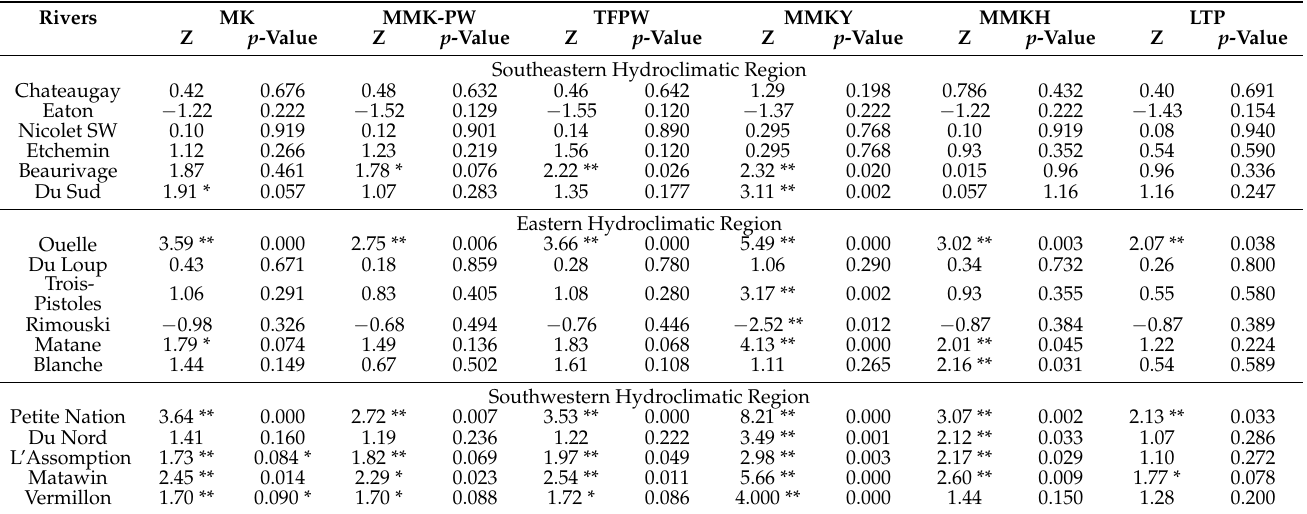
** = Statistically significant values at the 5% level; * = statistically significant values at the 10% level.